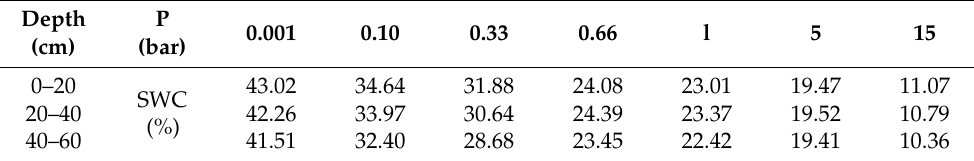
Table 3. Soil water content (%) versus suction pressure (bar).